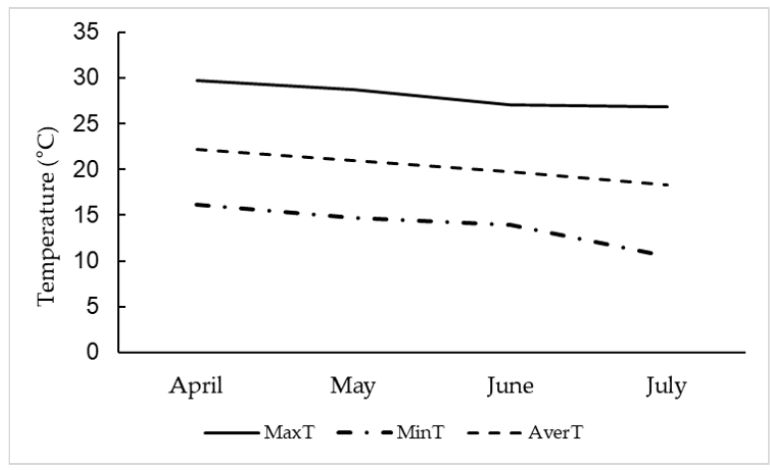
Figure 1. Meteorological data for the experimental period.